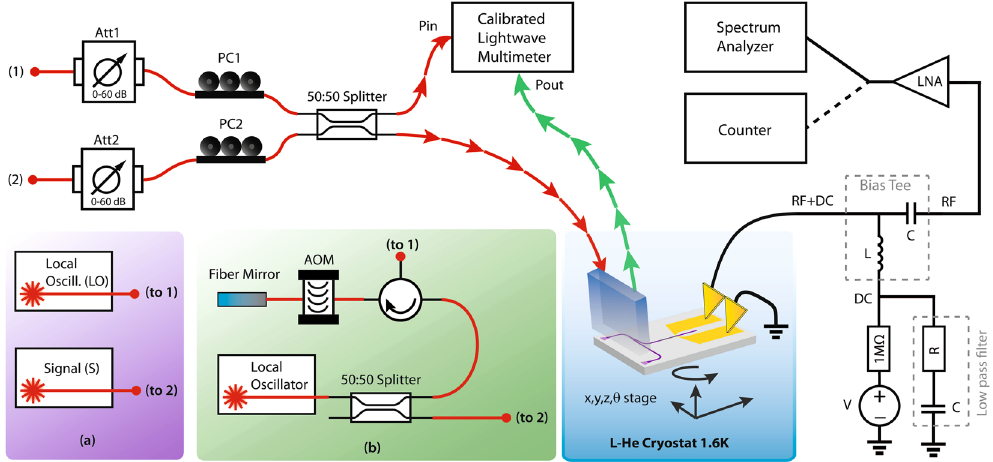
Figure 2. Experimental setups. Schematic view of the experimental setup for the single photon counting and the heterodyne mixing measurement. The nanophotonic device is mounted inside a liquid helium cryostat at a temperature of 1.6 K with optical access (red and green lines and arrows) and electrical access (black lines). ( a ) Coherent detection configuration in which two lasers are connected to points 1 and 2 in the basic scheme. ( b ) Single laser configuration for coherent detection, which allows us to use one laser source as LO and the signal. The generated laser light is divided in two by a 50:50 splitter. One branch of the splitter is directly routed to the mixing setup, while the second one is shifted by ≈ 400 MHz by the mean of an